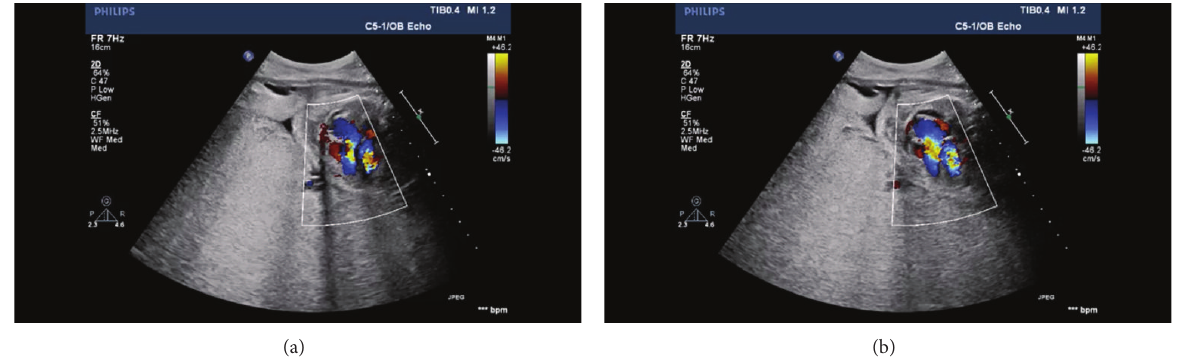
Figure 2: Pulsed wave Doppler examination demonstrating significant tricuspid regurgitation.